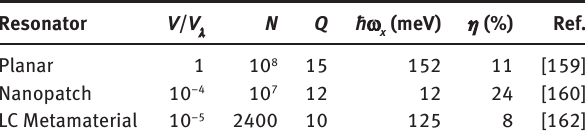
Table 3: Figures of merit for representative intersubband polariton samples using different